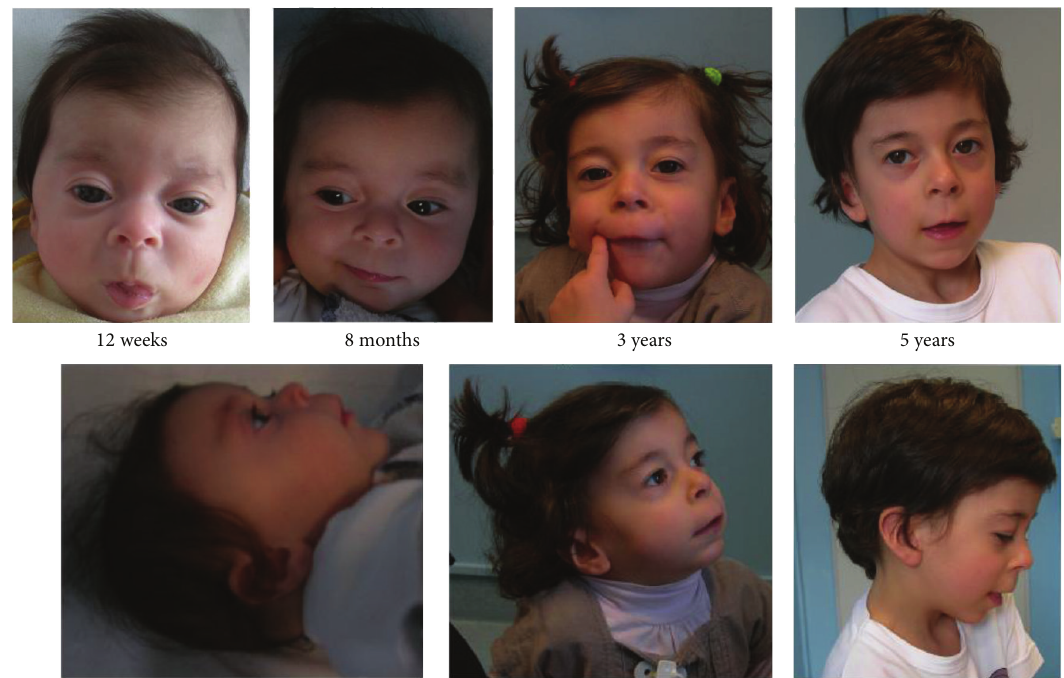
Figure 2: Proposita at 12 weeks, 8 months, 3 years, and 5 years